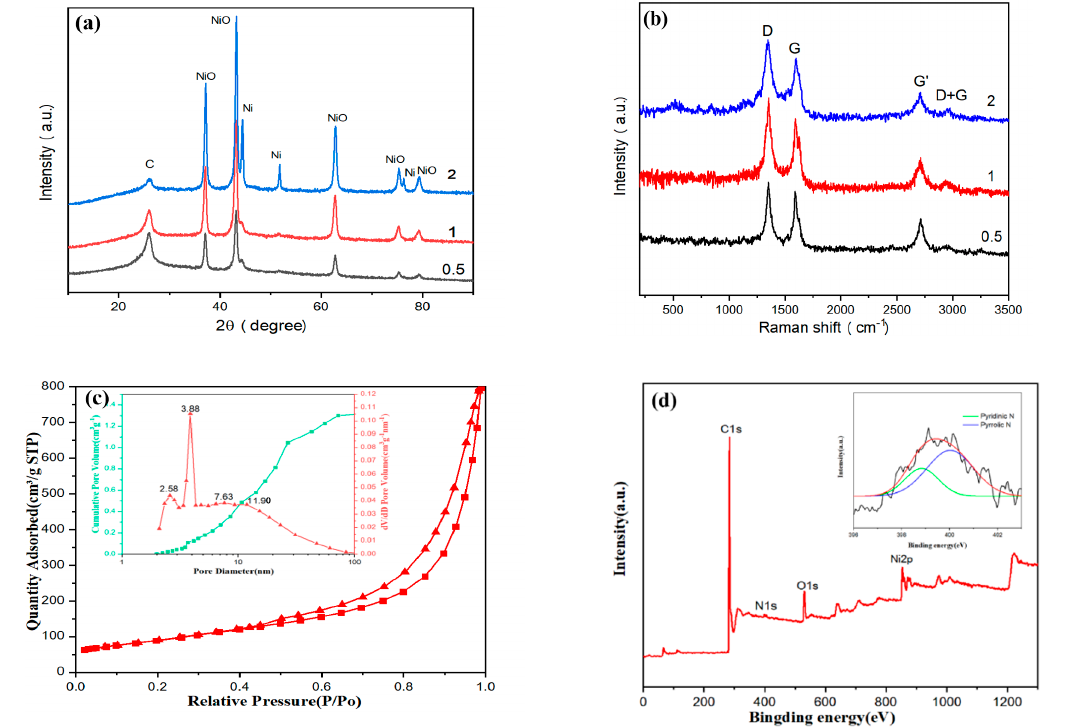
Figure 3. Phase characterization of NiO/Ni@C composite nanomaterials. ( a ) XRD (X-ray diffraction) spectra of the products at different precursors. ( b ) Raman spectra of NiO/Ni@C composite nanomaterials. ( c ) Adsorption and desorption curve of nitrogen. The corresponding pore diameter distribution curve is illustrated in figure c. ( d ) XPS (X-ray photoelectron spectroscopy) spectrum of NiO/Ni@C-2.